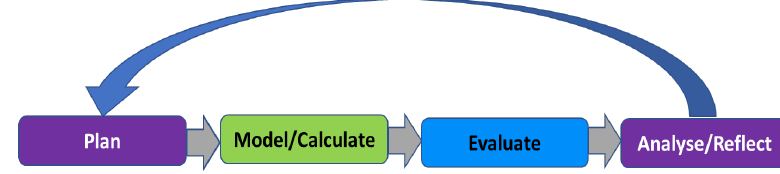
Fig. 2. Action-oriented research to adopt a critical approach that aims for